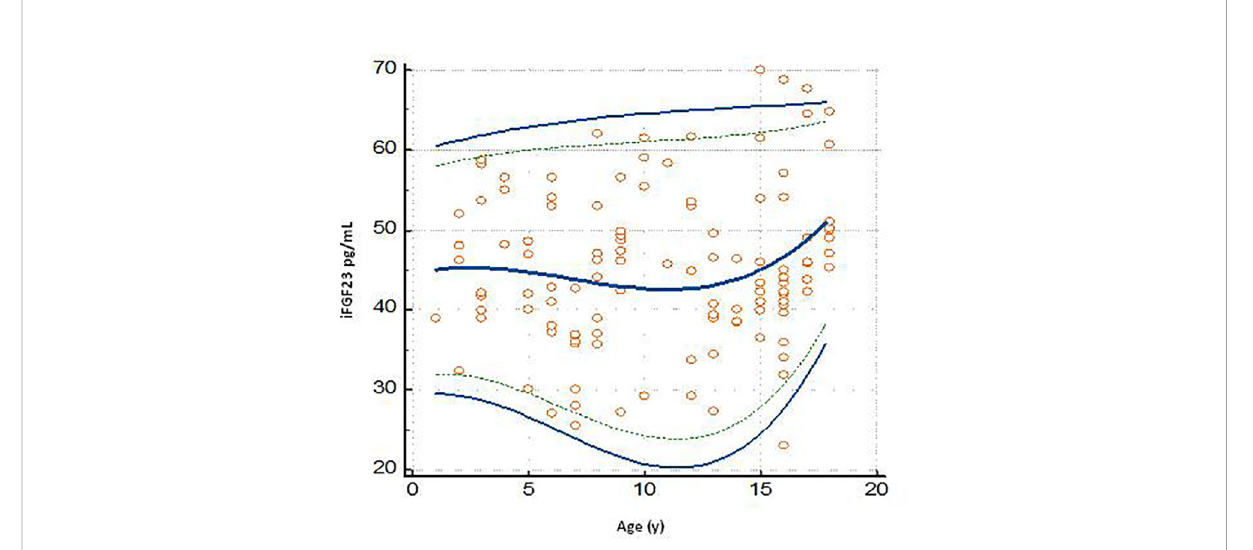
FIGURE 3 Plot of the scatter diagram of the measurements of iFGF23 versus age. The graph also shows the calculated mean (central line) and centile curves (solid line: 0.025-0.975 centiles; broken line: 0.05-0.95 centiles) to the individual